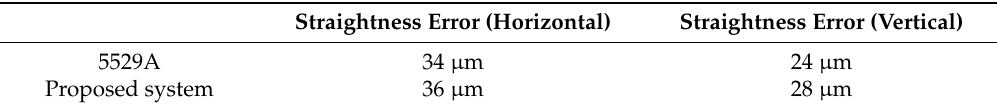
Table 6. Case 2 straightness error measurement results. Figure 21. Case 2 straightness error measurement setup on double column machine tool, ( a ) the double column machine tool and ( b ) the setup of 5529A laser interferometer straightness module and proposed system. Table 7. Case 2 straightness error measurement results.